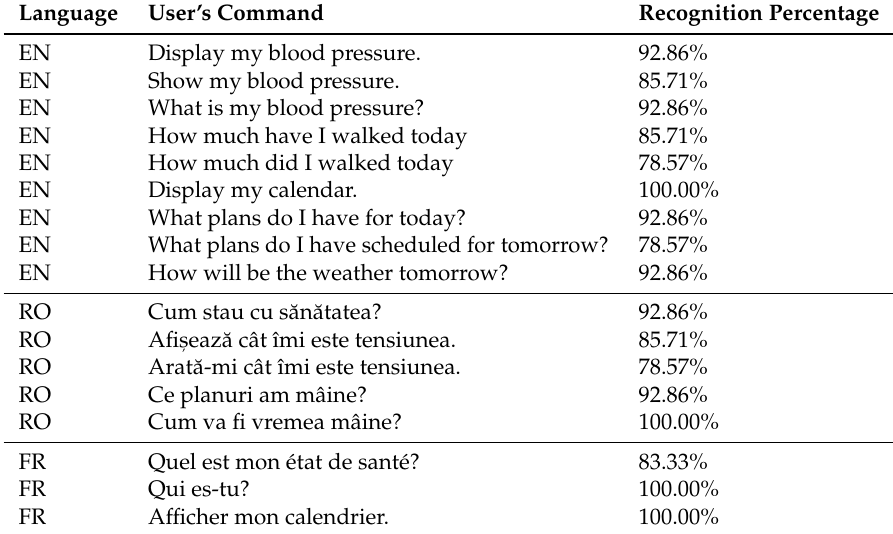
Table 2. Samples from the ASR evaluation